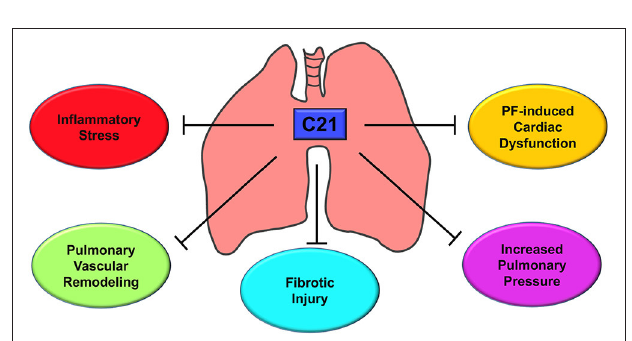
FIGURE 9 | Putative mechanism of action - AT 2 R stimulation by C21. C21 exerts a host of actions on the cardiopulmonary system that include decrease in lung inflammatory stress, reduction of pulmonary vascular remodeling, attenuation of fibrotic lung injury, lowering of pulmonary pressure, and improvement of cardiac function. All these properties are responsible for the protective actions of C21 against pulmonary fibrosis and associated cardiac